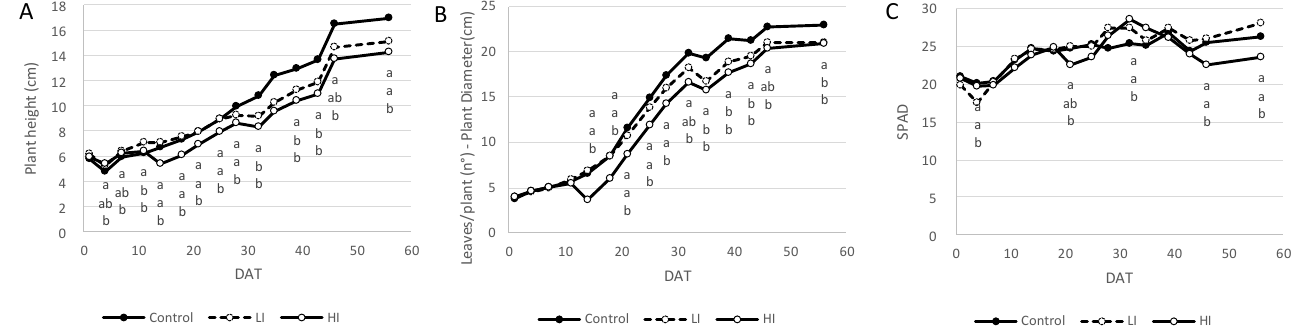
Figure 2. Effect of non-thermal-plasma-activated nutrient solution on plant height ( A ), number of leaves ( B ), plant diameter ( B ) and SPAD index ( C ). LI = low ionization intensity; HI = high ionization intensity; DAT = days after transplant. Within each parameter, values with different letters are significantly different at p < 0.05 based on the Tukey HSD test.